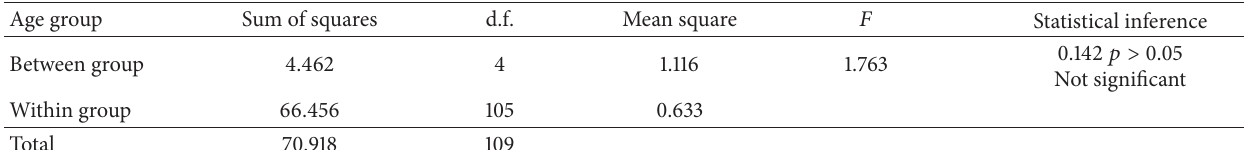
0.142 𝑝 > 0.05 Not significant